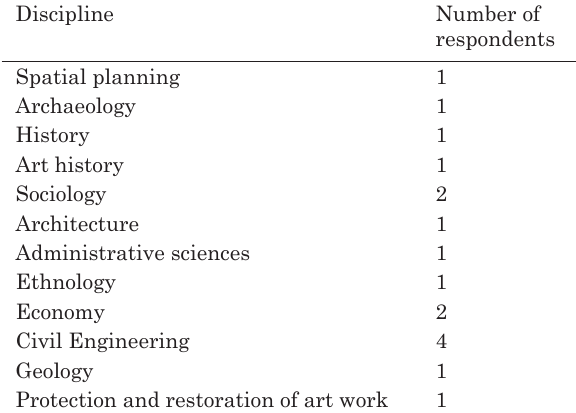
Table 2. Disciplines, represented in the sample of experts collaborating in the AHP analysis